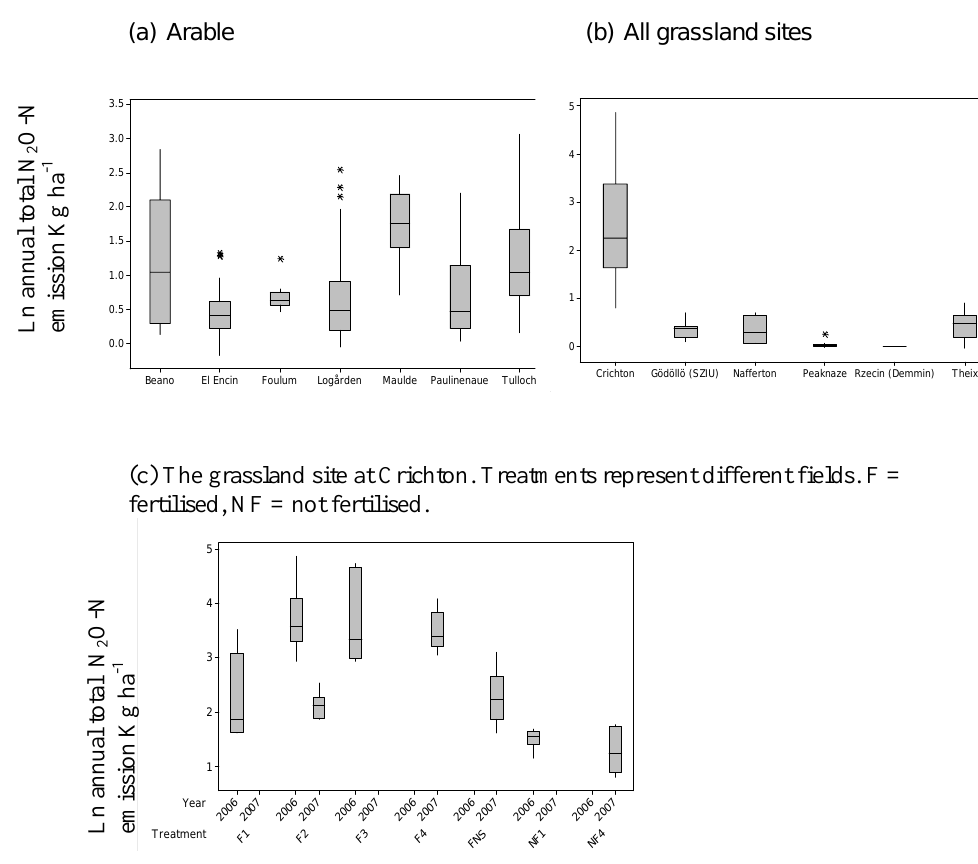
Fig. 2. Annual N 2 O emissions compared between sites. Each bar represents the average emission from different treatments in different years. Each bar indicates the mean (central bar), upper and lower quartiles (outside bar) and 95% range (lines). Outliers are represented by asterisks. See Table 3 for a description of the detailed treatment